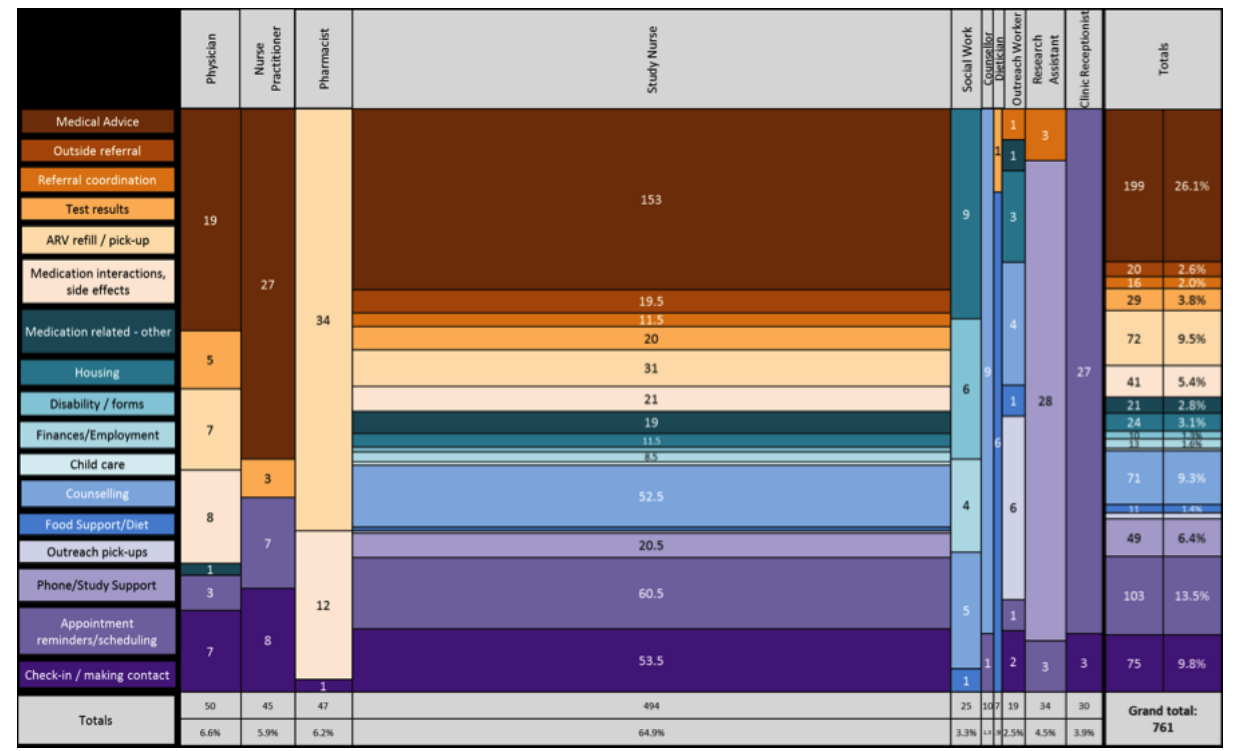
Figure 5. Nature and frequency of problem-response interactions that health care providers solved over intervention